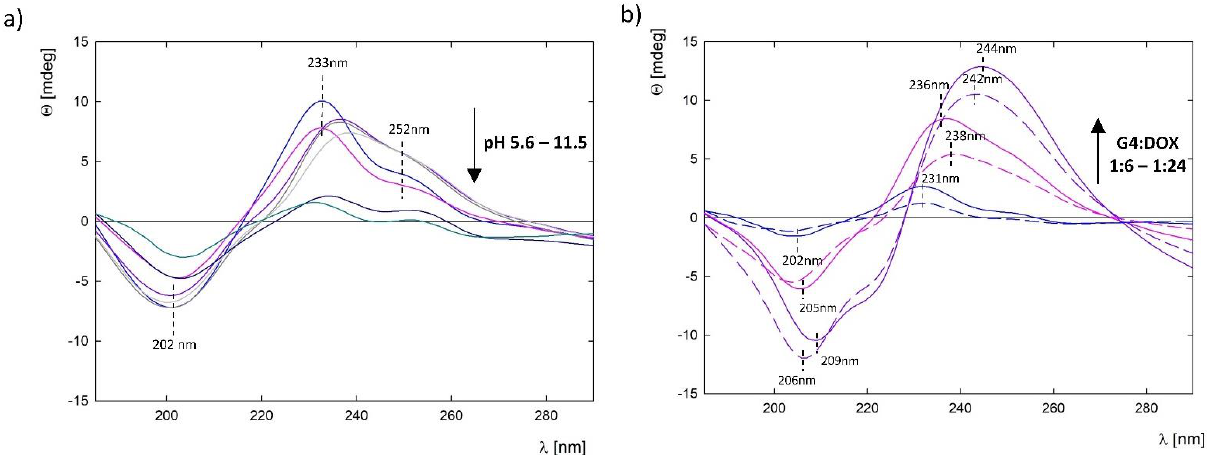
Figure 10. CD spectra for ( a ) DOX at a concentration of 0.1 mg/mL in the pH range of 5.6 – 11.5; ( b ) G4.0 PAMAM-DOX complexes depending on the molar ratio after 24 h of mixing (dark blue line: 1:6, pink line: 1:12, purple line: 1:24; solid lines: complex before dialysis, and dashed lines: complex after dialysis).